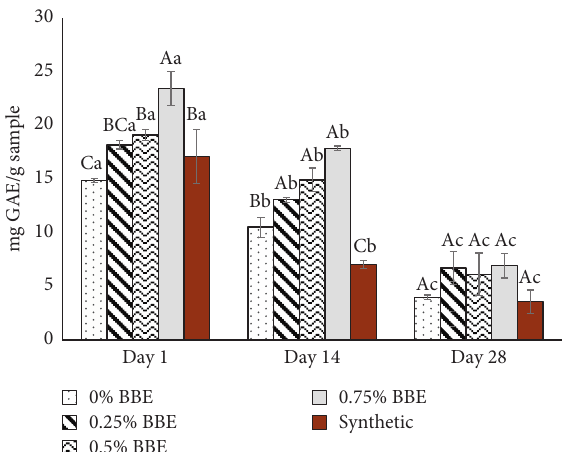
Figure 1: The total phenolic content (mg GAE/mg sample) of fish sausages samples fortified with 0%, 0.25%, and 0.5% BBE and synthetic additives BHT. Values of means ± standard deviation (SD) of triplicate independent experiments. Different capital letters indicate significant differences ( p < 0 . 05) within the samples in the same day. Different small letters indicate significant differences ( p < 0 . 05) of the same sample across the storage days 1, 14, and 28 at 4 o